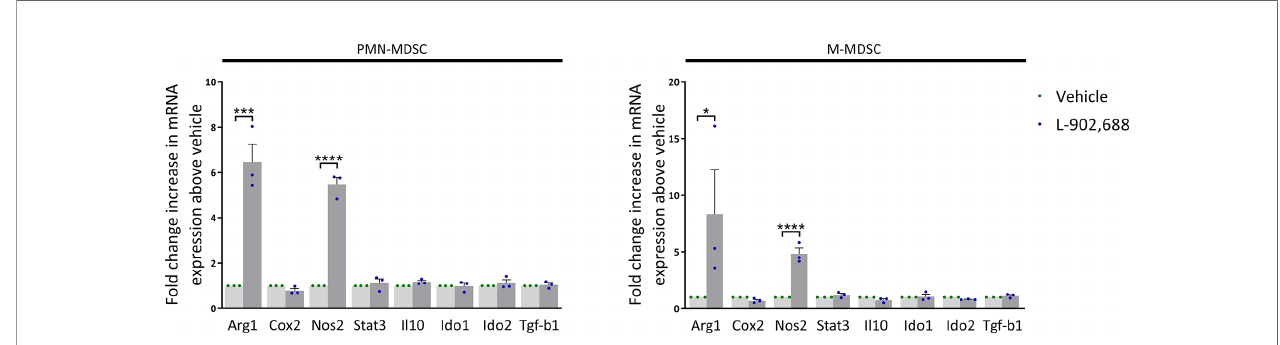
FIGURE 3 | The effect of the EP4 agonist L-902,688 on mRNA expression of MDSCs. Bone marrow cells isolated from hind legs of 6- to 8-week-old female BALB/ c mice were cultured in the presence of the EP4 agonist L-902,688 (10 µM) or vehicle, in combination with GM-CSF (20 ng/ml). After 3 days of culture, both PMN- and M-MDSCs were isolated. RNA was isolated and the gene expression of Arg1 , Cox2 , Nos2 , Stat3 , Il-10 , Ido1 , Ido2 and Tgf-b1 were quanti fi ed by qPCR. Expression shown as fold change increase in mRNA above vehicle. Data was normalised to Gapdh expression. Data was obtained from 3 independent experiments with 2 technical replicates per experiment. Results of individual experiments and mean ± SEM are shown. Statistical analysis was performed with unpaired one-tailed Student ’ s t-test. * p < 0.05, *** p < 0.001, **** p < 0.0001.